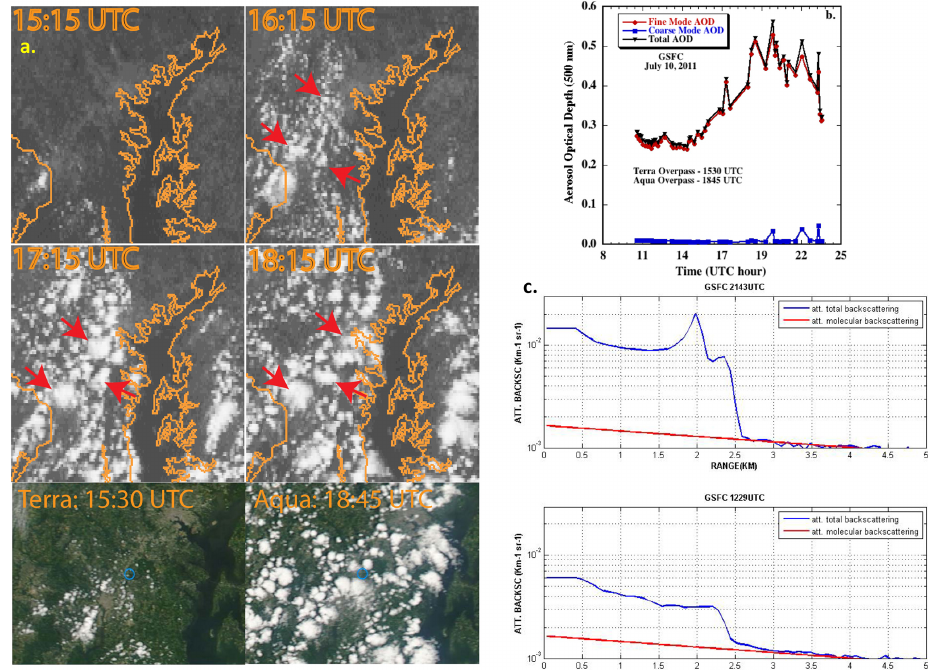
Figure 8. (a) GOES 13 images from 10 July 2011 at four observation times over a 3h interval, with fixed location red arrows to show relative movement and growth of cumulus cells. Bottom row shows Terra and Aqua MODIS images acquired on 10 July 2011, centered on the GSFC site (blue circle). (b) The time series of fine and coarse mode AOD at the GSFC site for this same date. (c) Attenuated backscatter vertical profiles measured from micro-pulse lidar network (MPLNET) at the GSFC site on this same date from before and after cumulus formation, depicting both total and molecular